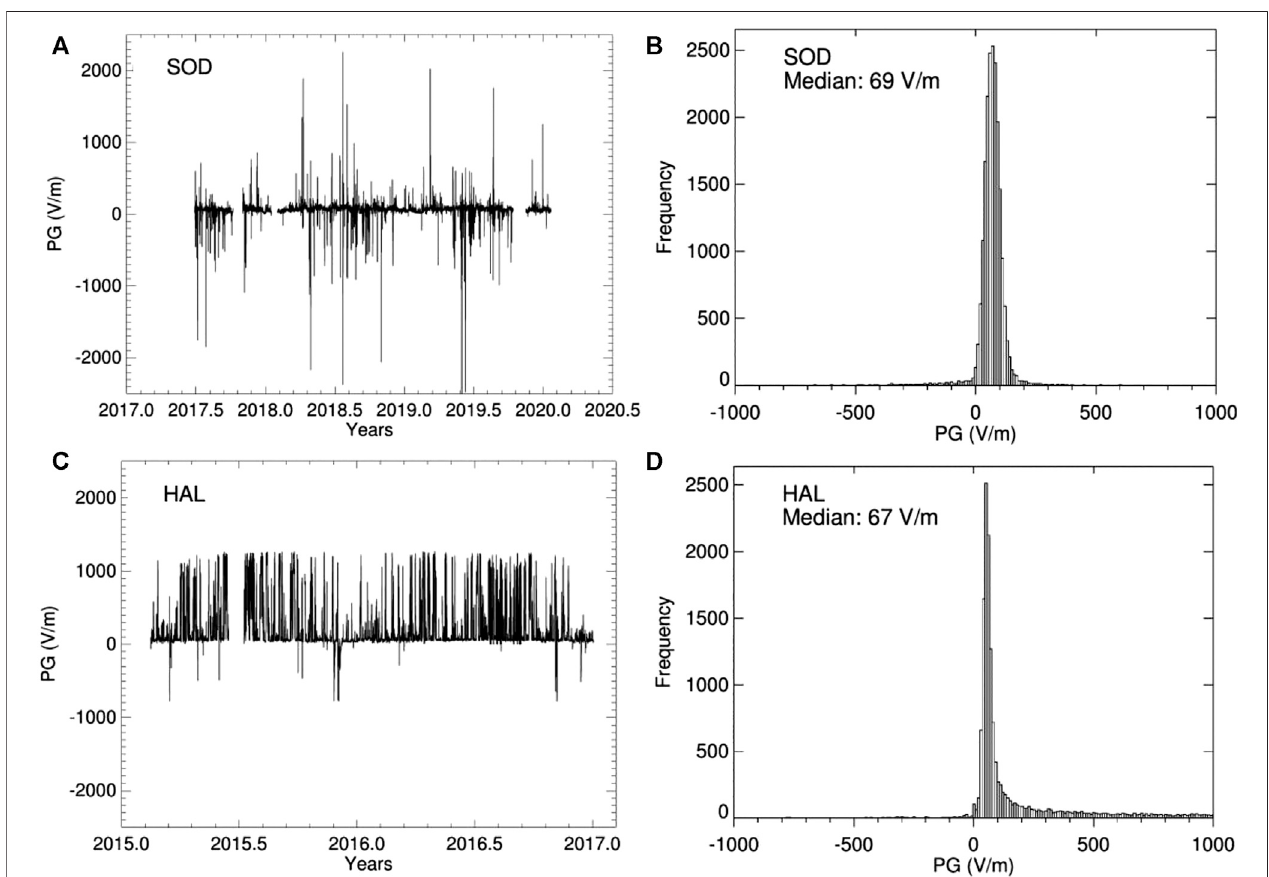
FIGURE2| Times series ofPGfor (A) Sodankyla,SOD, and (C) Halley, HAL, stations. PGhistogram for (B) SOD and (D) HALstations, forhourly mean valuesand plotted within a range of ± 1000 V/m.